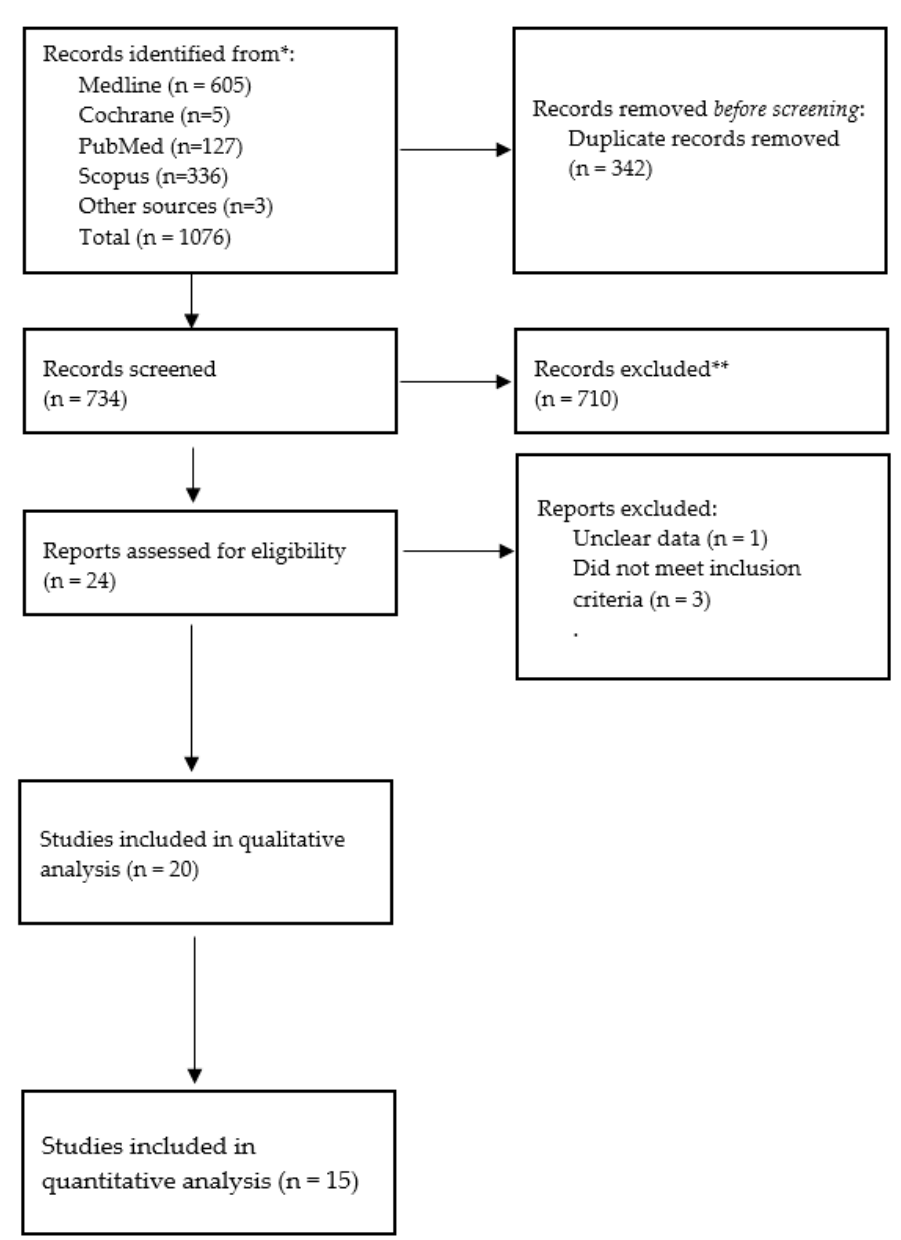
Figure 1. PRISMA flow diagram summarizing the study selection process for eligible trials. *